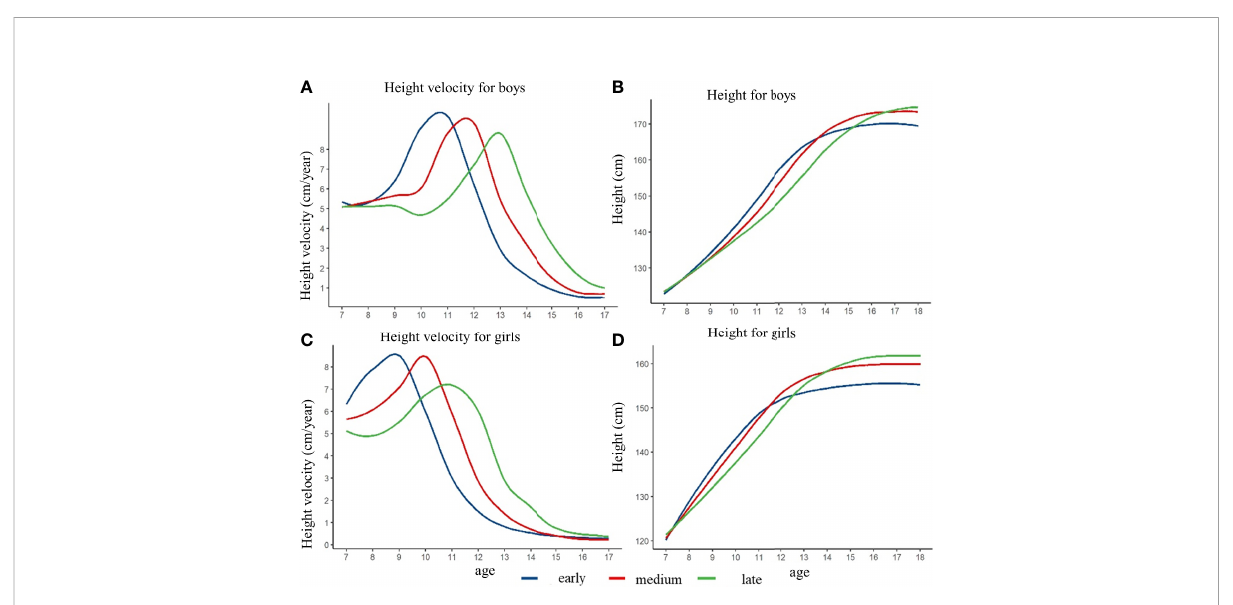
FIGURE 2 The height growth trajectory of boys and girls with different height spurt timing (APHV) after matching the pre-pubertal height at baseline. (A) height velocity for boys; (B) height for boys; (C) height velocity for girls; (D) height for girls.